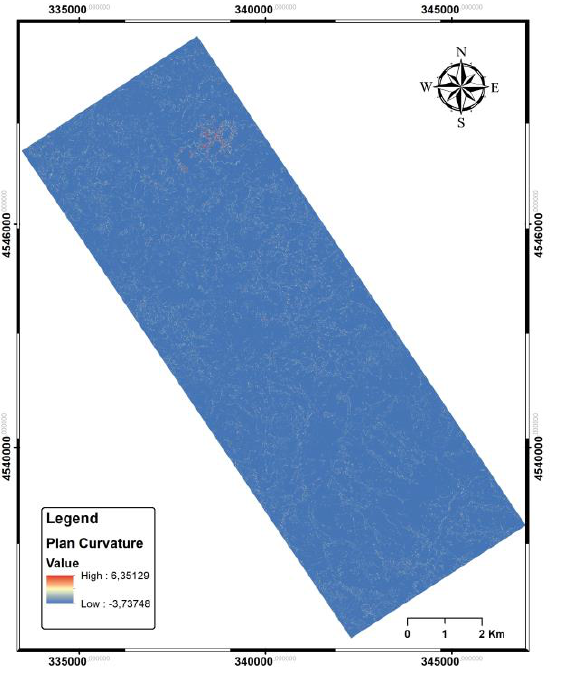
Figure 8. Plan slope curvature map of the study area.